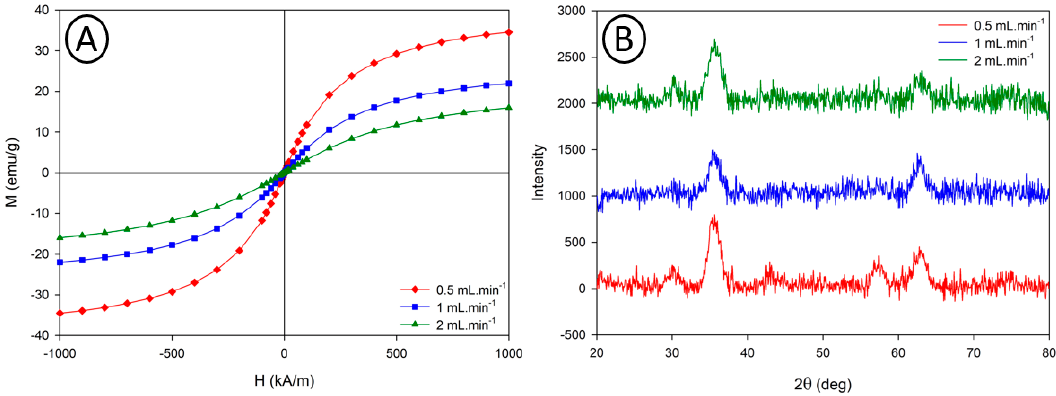
Figure 11. Magnetization curves ( A ) and XRD diffraction patterns ( B ) of samples obtained in the 2.4 mm capillary reactor.